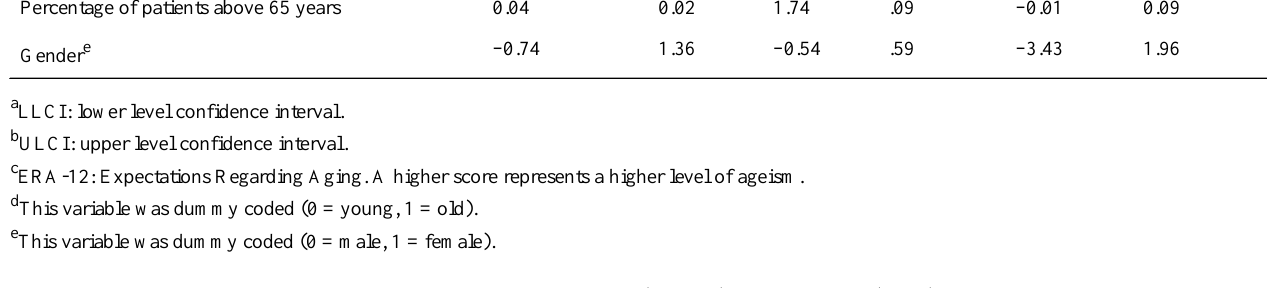
Figure 3. Moderation of the correlation between ATOAUT and ageism (ERA-12) by age salience (N=92). ATOAUT: attitudes toward older adults using technology; ERA-12: Expectations Regarding